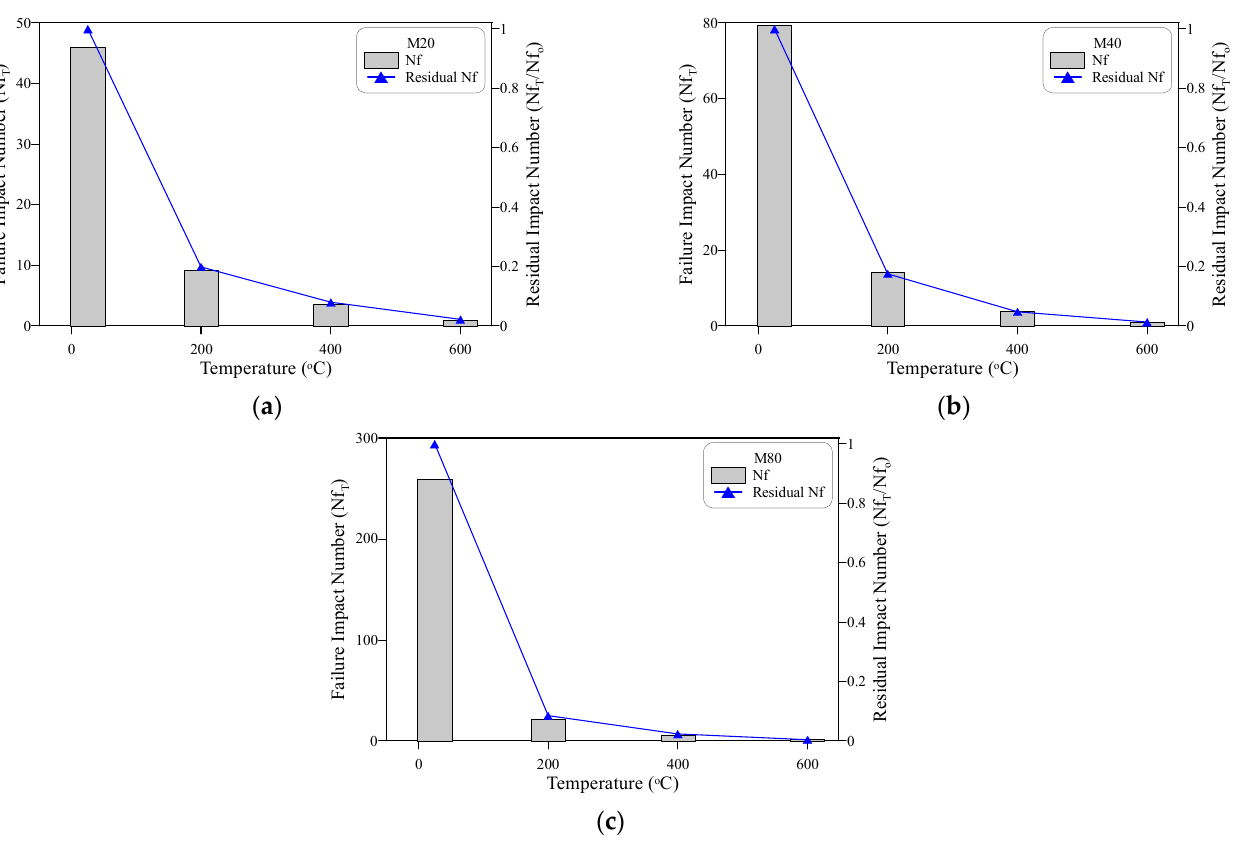
Figure 12. Failure impact number at different temperatures: ( a ) M20, ( b ) M40, ( c ) M80.